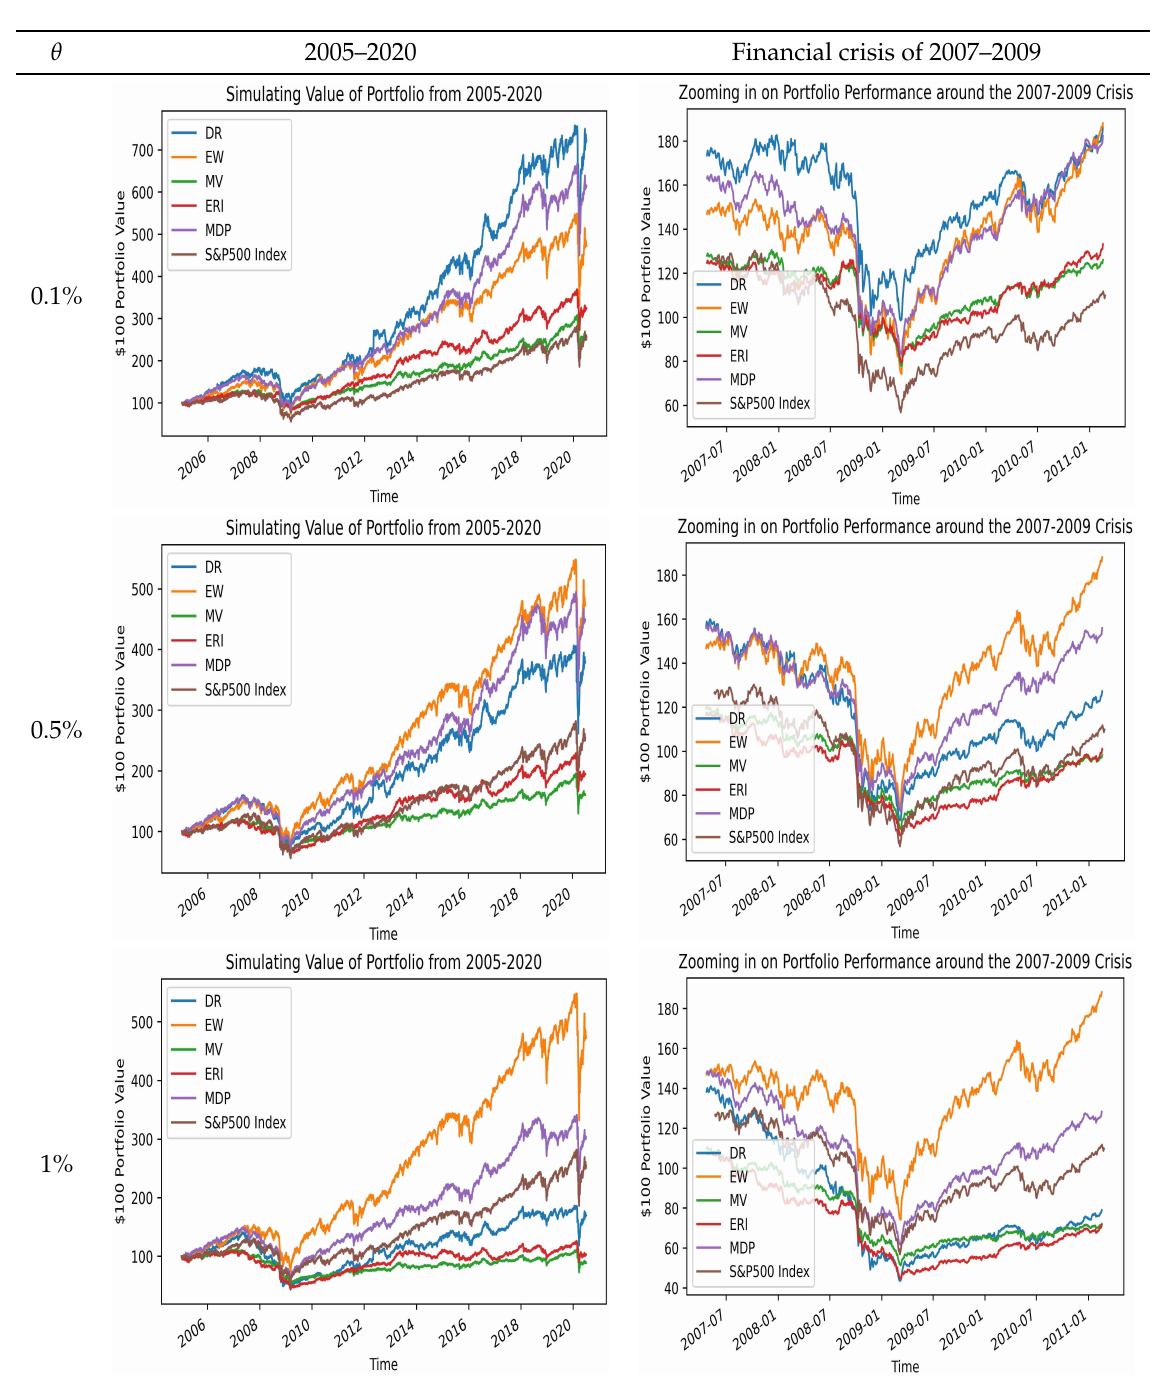
Figure 6. Portfolio value of 361 stocks with transaction cost θ = 0.1%,0.5%,1% and θ fc = 1.5 θ . We further plot the optimal weights for DR, MV, ERI, and MDP at each